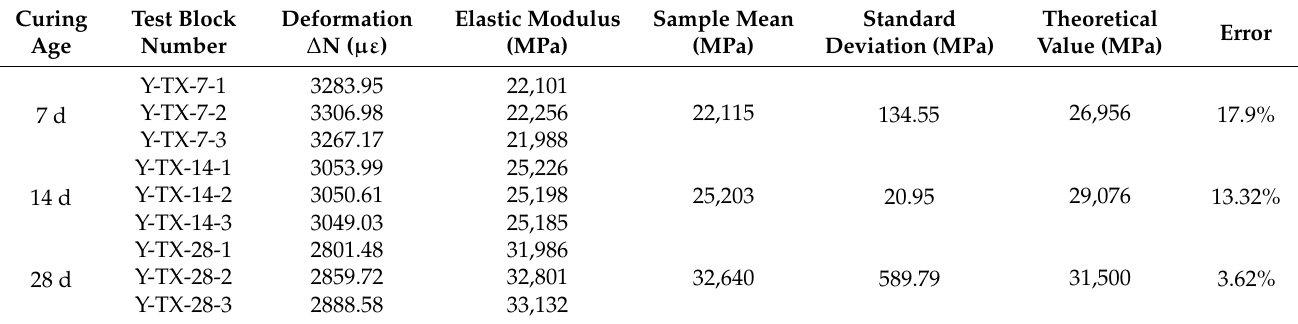
Table 2. Elastic modulus of C35 concrete at different ages.